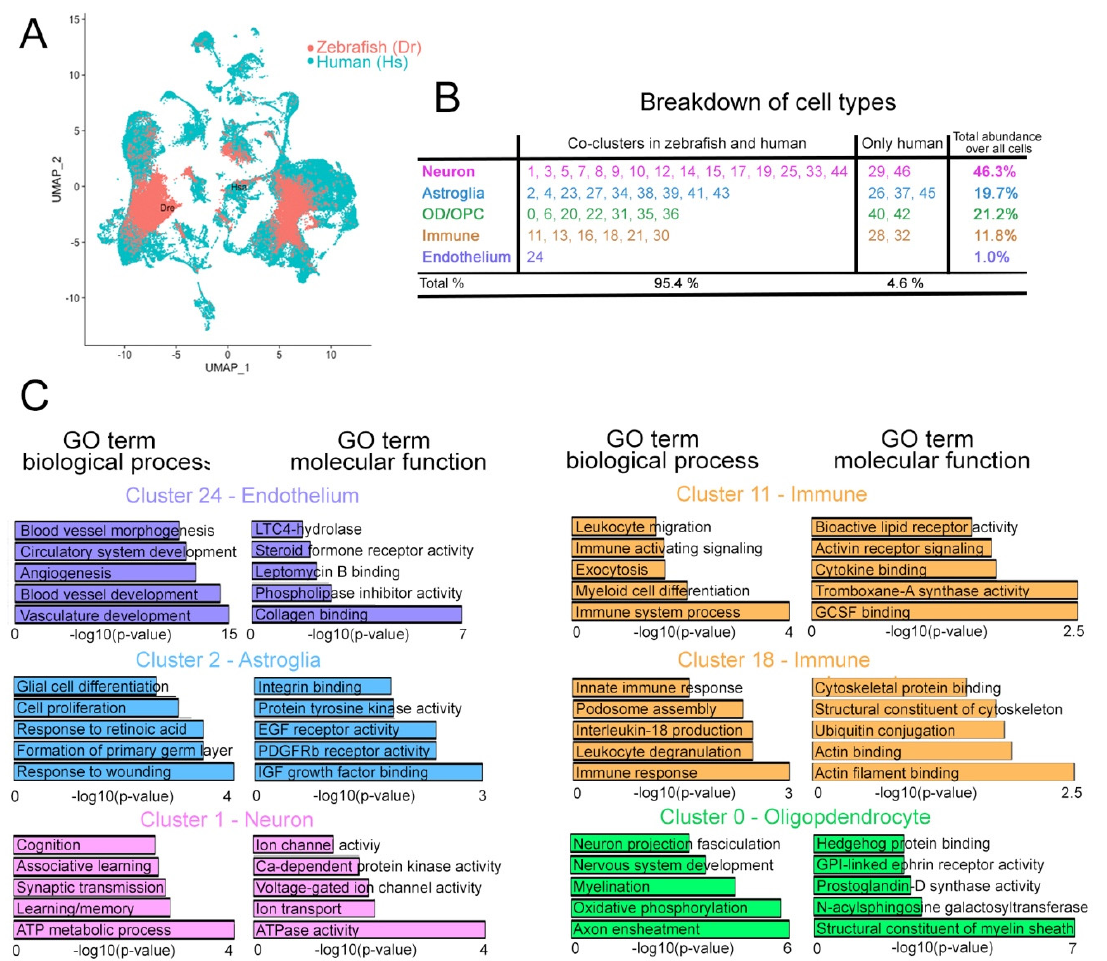
Figure 4. Analyses of the composite human–zebrafish single cell clusters. ( A ) Color-coded breakdown of the cells on the composite tSNE plot. Green: human cells; red: zebrafish cells. ( B ) Table showing the cluster numbers, identities, their co-clustering status in human and zebrafish, and the abundance of cells in those clusters. 95.4% of all cells on the composite tSNE plot can be co-clustered in humans and zebrafish. 4.6% of all cells are only in human clusters. ( C ) GO term enrichment graphs for the representative endothelial, neuronal, astroglial, immune, and neuronal clusters. See Figures S3 and S4, Datas S2 and S3.